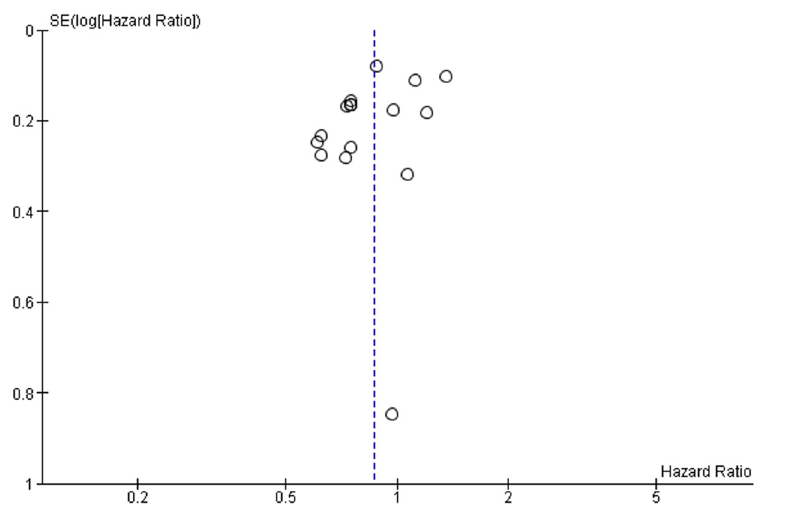
Fig 5. Funnel plot to detect publication